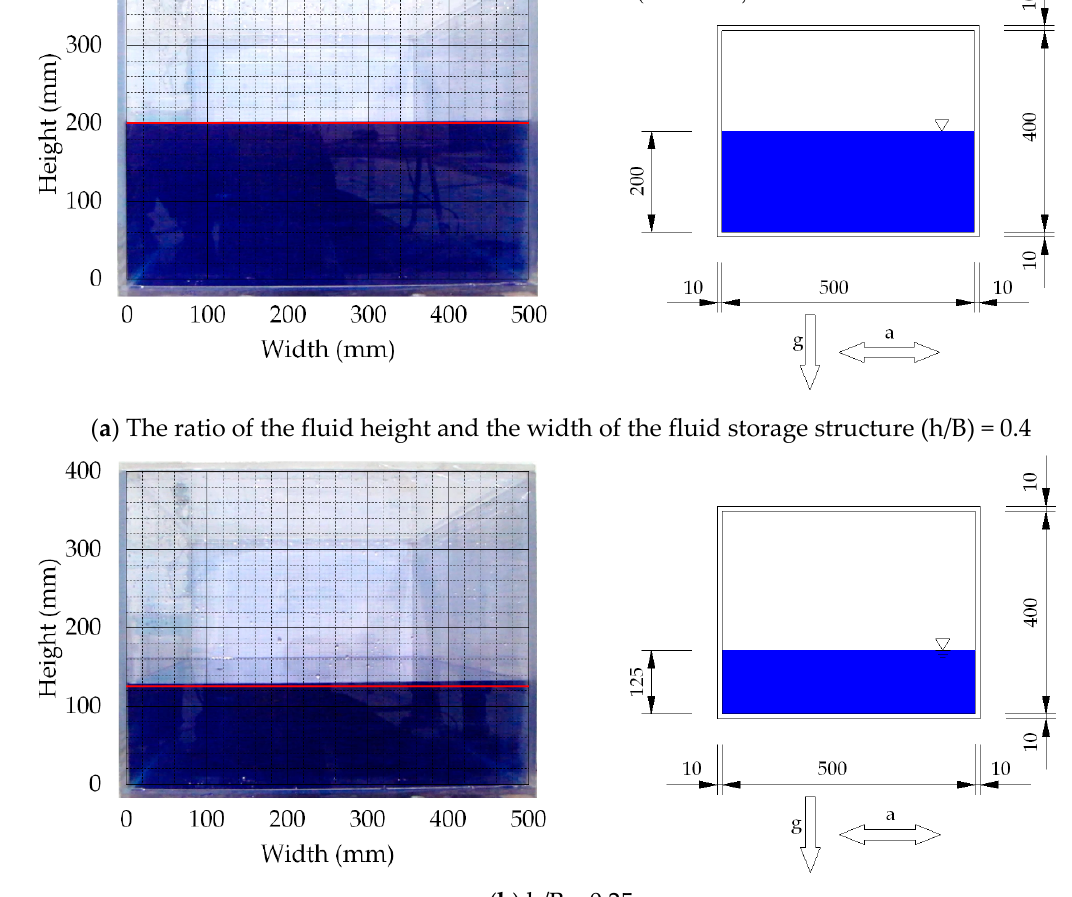
Figure 1. Scaled model and specification.